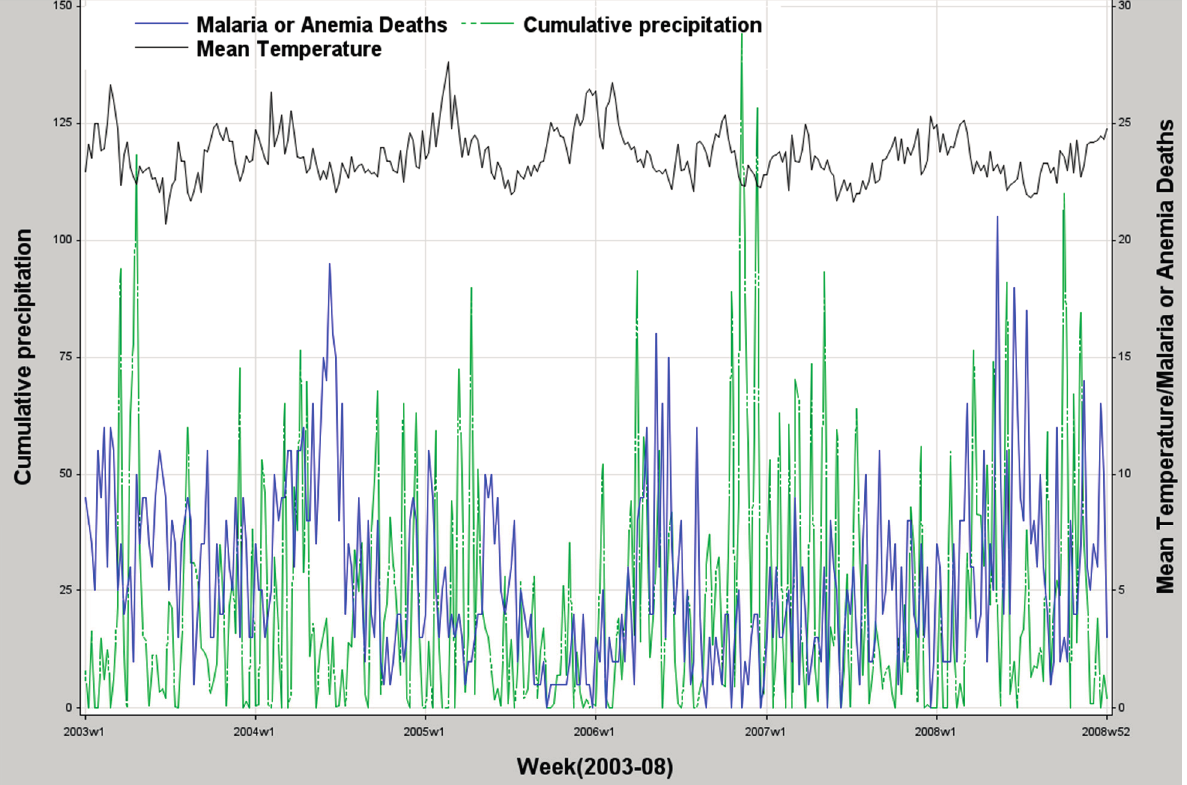
Figure 2. Weekly malaria/anemia deaths among children under five years, mean temperature (°C) and cumulative precipitation (mm) in